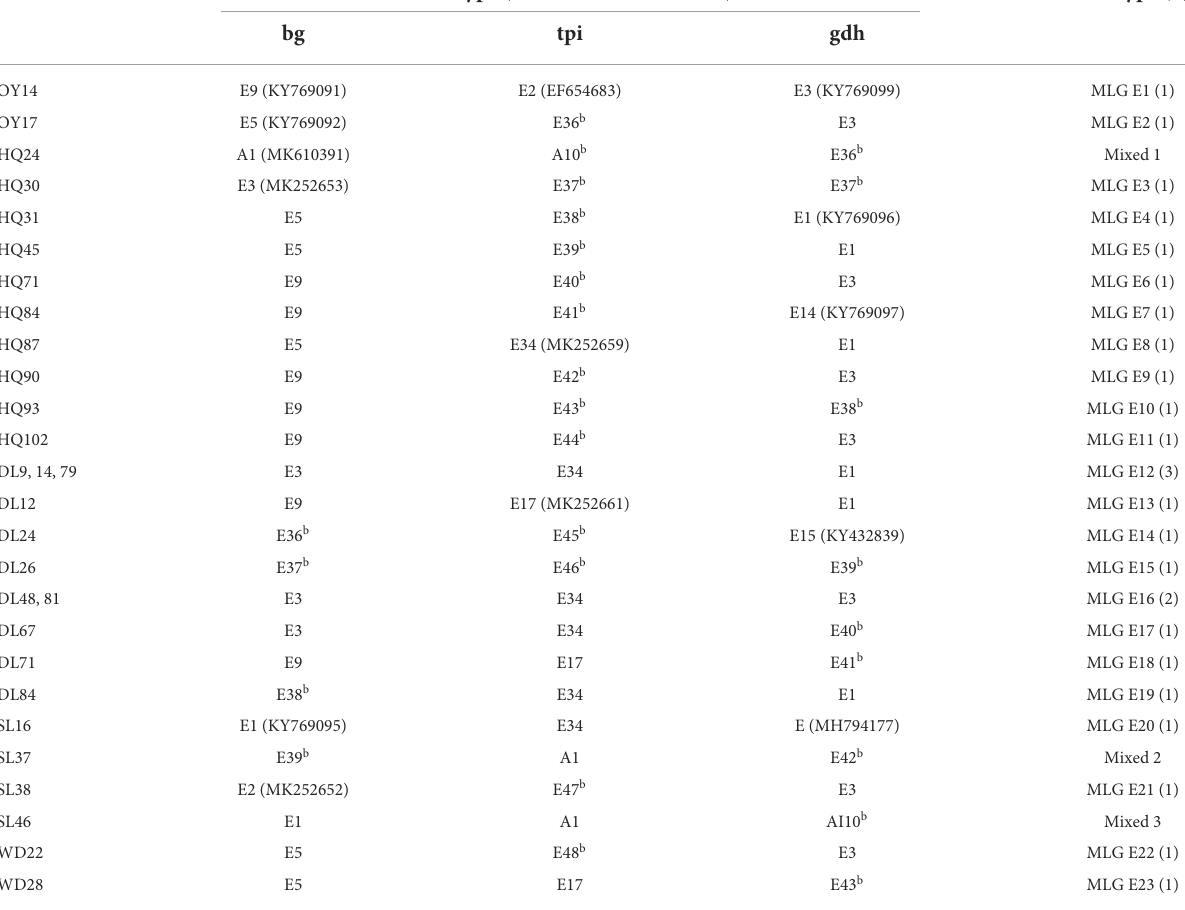
TABLE 4 Multilocus sequence genotypes of Giardia duodenalis assemblage E in Holstein cattle in Yunnan Province. Isolate Genotype (GenBank accession